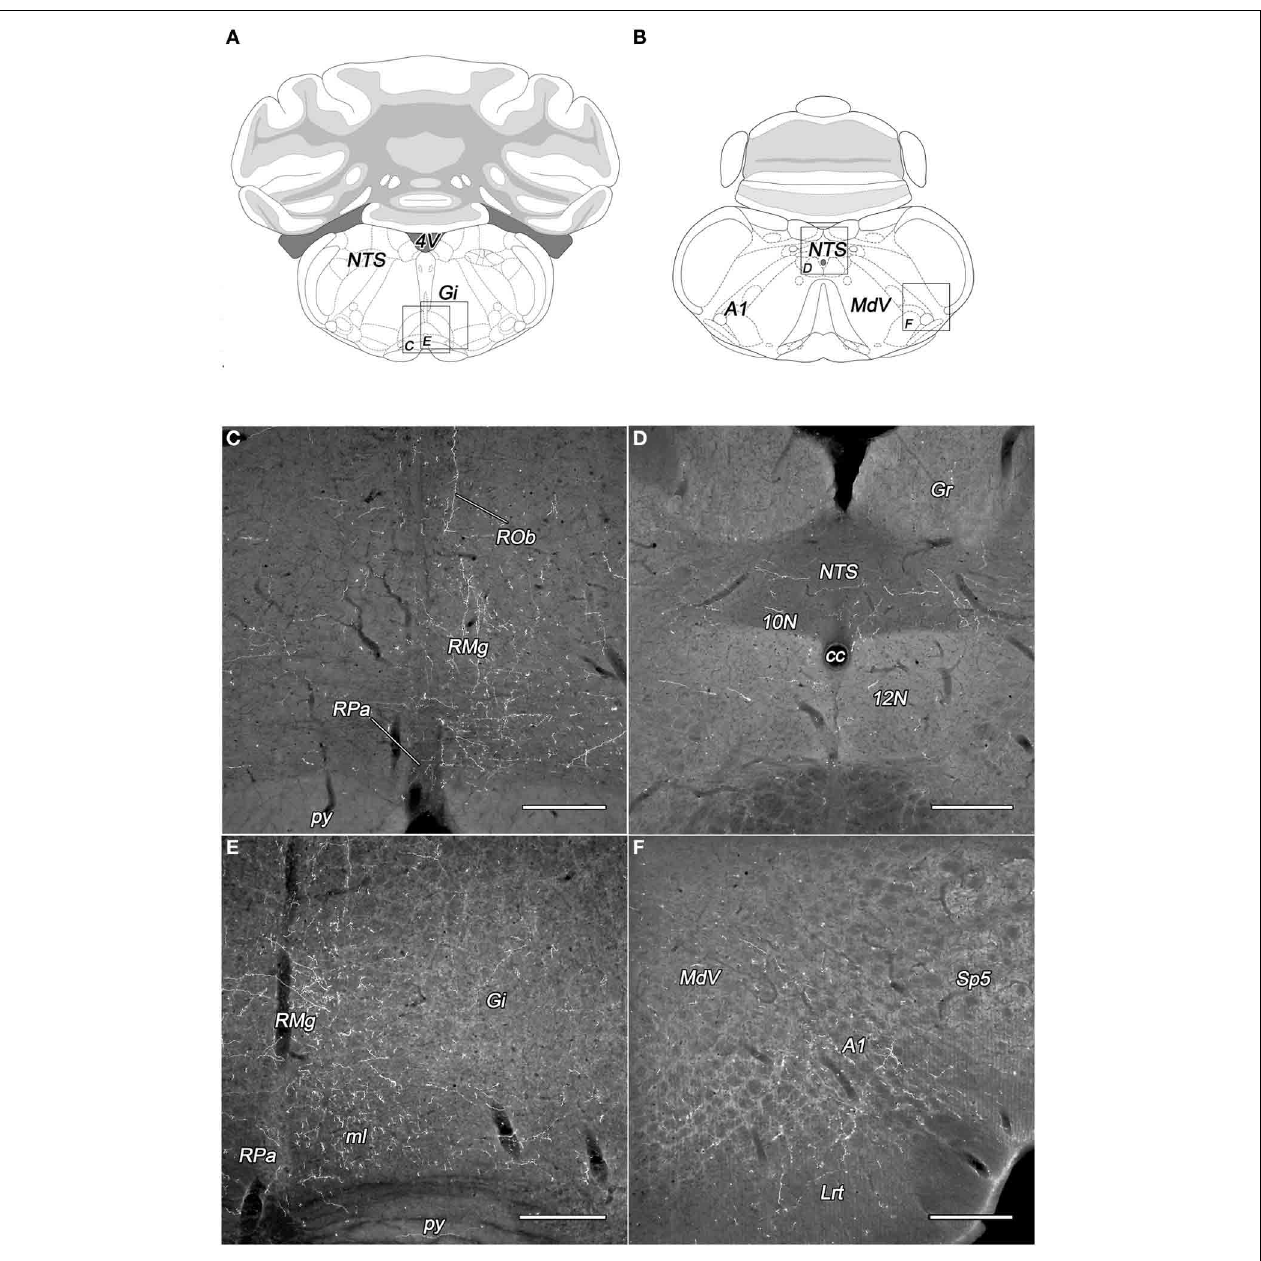
FIGURE 6 | Labeled fibers in the lower brainstem following BDA injections into different subregions of the DLH. Drawings with outlined areas for panels C and E (A) and panels D and F (B) according to the atlas of Paxinos and Watson (2007), with modifications. Dense networks of BDA-containing fibers in various densities were seen in the raphe pallidus, obscurus, and magnus nuclei originating from the caudomedial perifornical area (C,E) . The distribution of the BDA-containing fibers is mainly ipsilateral to the injections (C) . Varicose BDA-labeled fibers were found in the caudal part